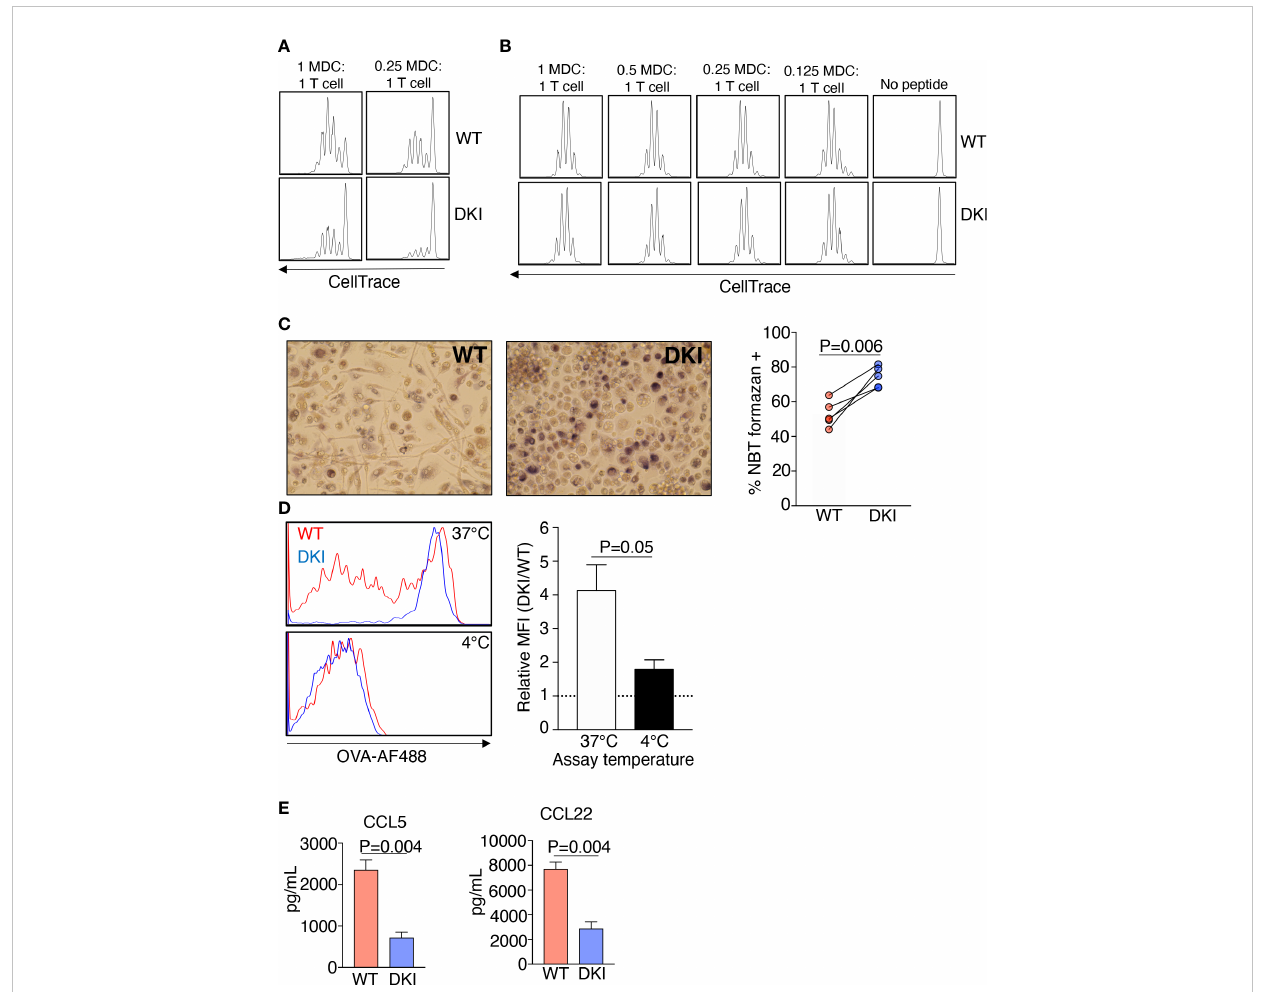
FIGURE 2 STAT5 Tetramers Control the Functions of MDCs. (A-E) WT and DKI bone marrow monocyte were differentiated for 8 d with GM-CSF. (A, B) Naïve OT-II CD4 + T cells were labeled with CellTrace Violet and were co-cultured with WT or DKI MDCs at different ratios in the presence ovalbumin protein (A) or OVA (323-339) peptide (B) for 72 h. Representative histograms showing the dilution of CellTrace Violet. Data are from 3 independent experiments. (C) Percent of WT and DKI MDCs containing NBT formazan deposits following 1 h stimulation with LPS and 15 min incubation with nitro blue tetrazolium. Representative images are shown. Data are from 5 independent experiments. (D) Representative histogram showing the ability WT and DKI MDCs to phagocytose fl uorescently conjugated ovalbumin. Incubation at 4°C was used as a negative control to omit any signal from fl uorescently conjugated ovalbumin bound to the surface of the cells. DKI MFI relative to WT MFI is shown. Data are combined from 5 independent experiments. (E) Expression of CCL5 and CCL22 in the culture supernatants of WT and DKI MDCs. Data are combined from 3 independent experiments. (C – E) Data shown are mean ± SEM. Statistical signi fi cance is indicated by the P-value with NS meaning no statistical signi fi cance. (C) Paired t test. (D, E) Unpaired t